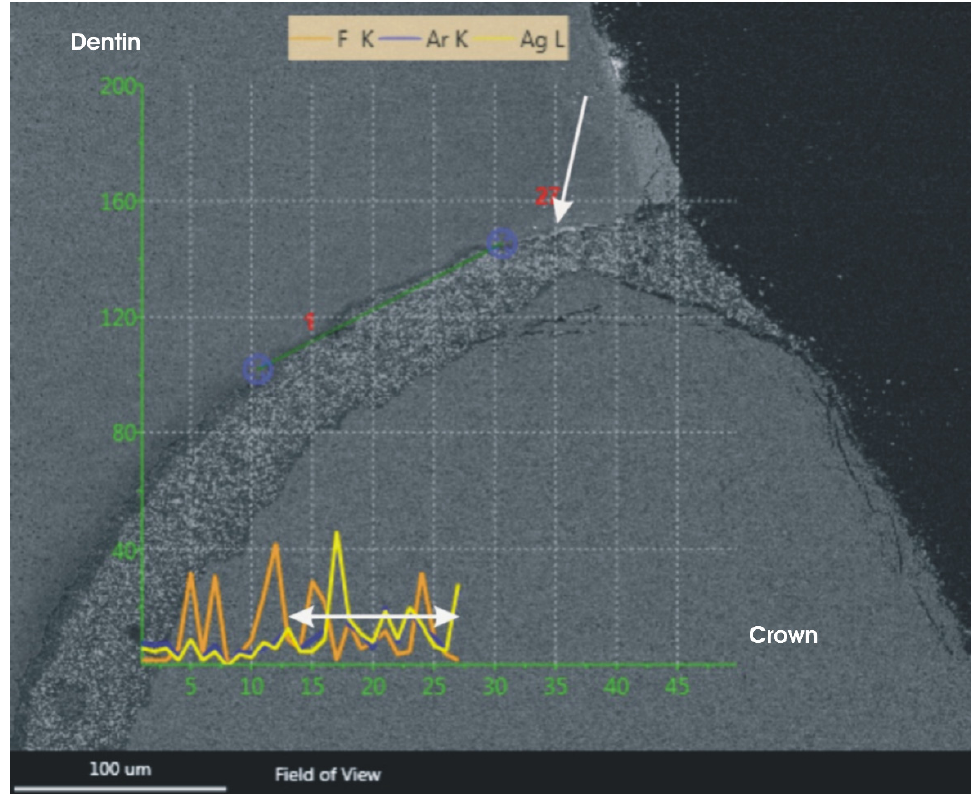
Figure 1. Linescan of a silver precipitation within the gap of the microleakage. The silver precipitation is marked with an arrow. The depth of the silver precipitation is marked with a double-headed arrow along the yellow curve of the EDS